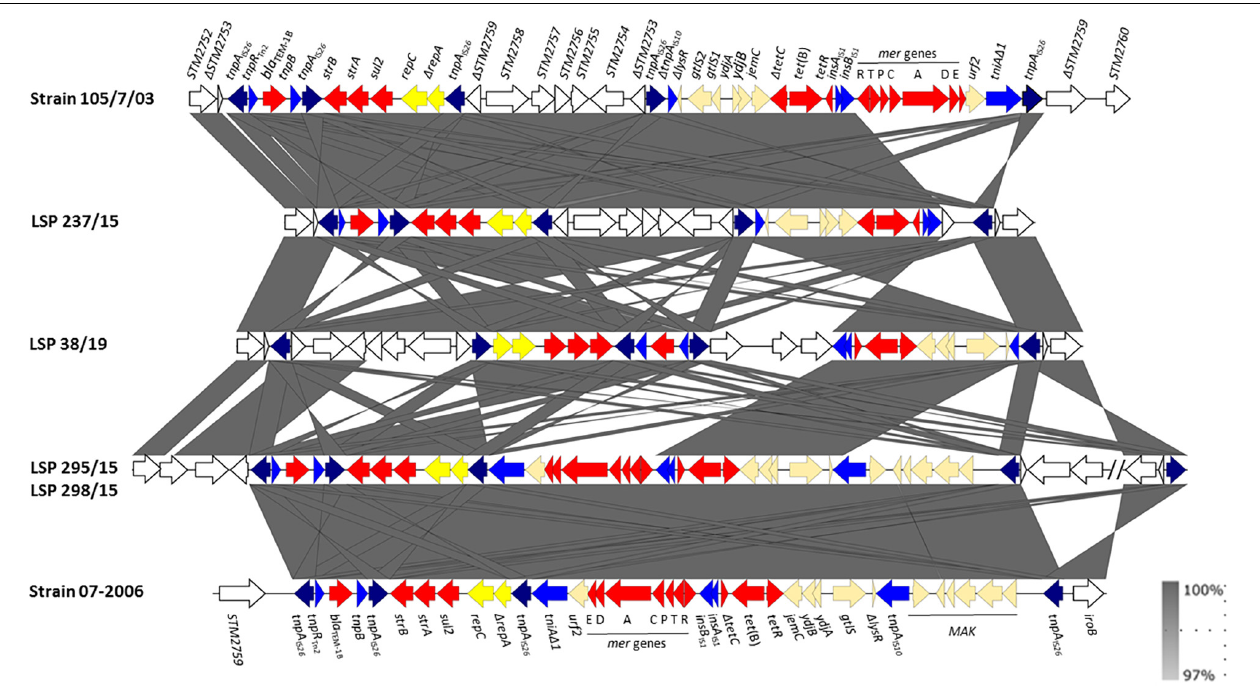
FIGURE 3 | Genetic organization of the tetra-resistance regions found in food-borne isolates of the European monophasic clone. The alignment was created with EasyFig BLASTn including the tetra-resistance regions of strains 105/7/03 (accession number HQ331538, shown above) and 07-2006 (accession number KR856283; shown below) for comparison. The open reading frames (ORFs) are represented by arrows pointing to the direction of transcription and having different colors according to their origin or roles: white, chromosomal ORFs of the S . Typhimurium LT2 chromosome (named according to accession number NC_003197); red, resistance; blue, DNA mobility, with the tnpA gene of IS 26 shown in dark blue; yellow, plasmid replication genes; pale orange, other roles. The gray shading between the structures connects regions of nucleotide sequence similarity ranging from 97 to 100%, according to the scale shown at the lower right part of the